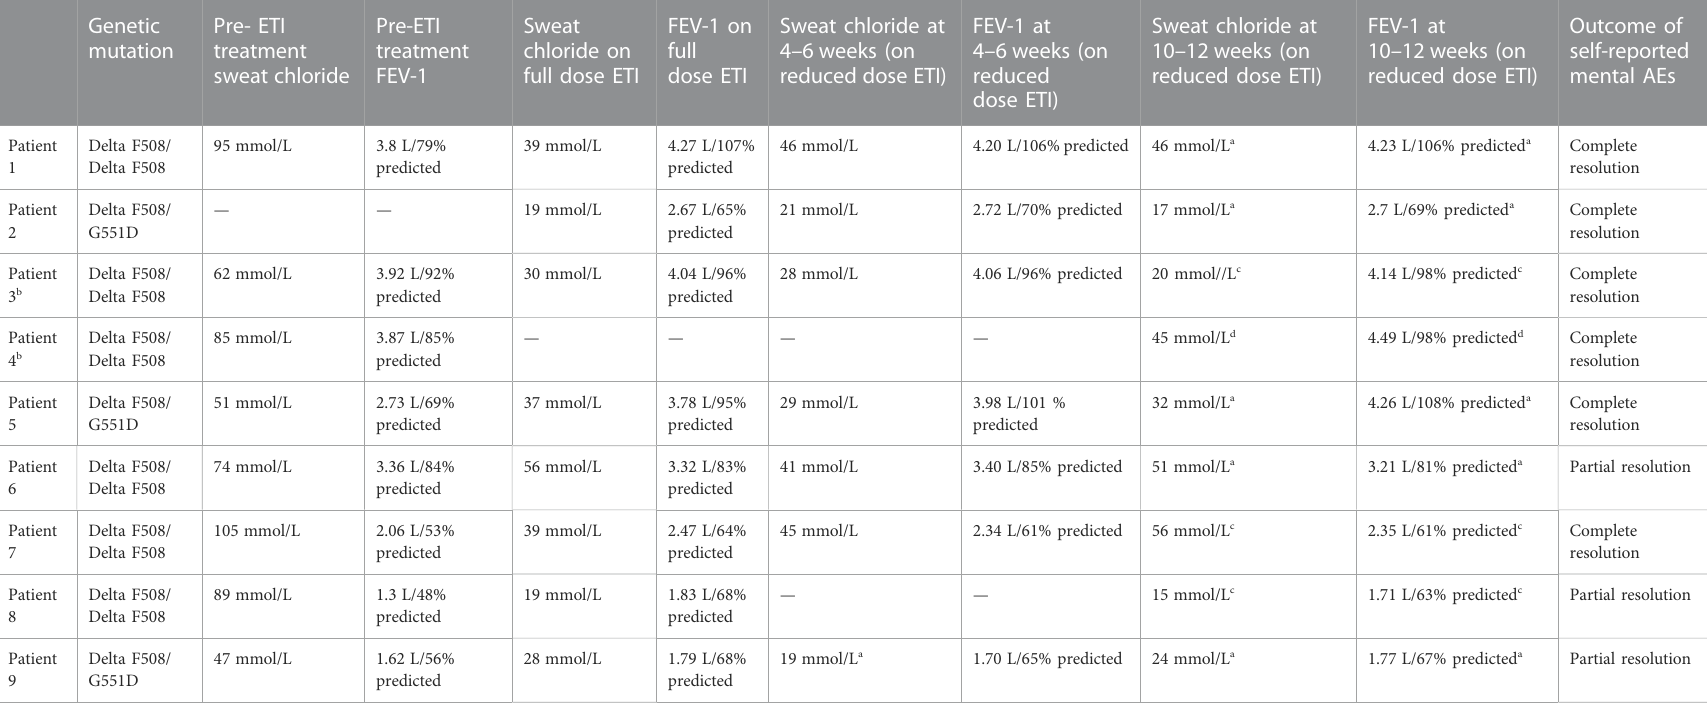
TABLE 1 Comparison of clinical ef fi cacy parameters pretreatment, on full dose, and reduced dose of elexacaftor/tezacaftor/ivacaftor